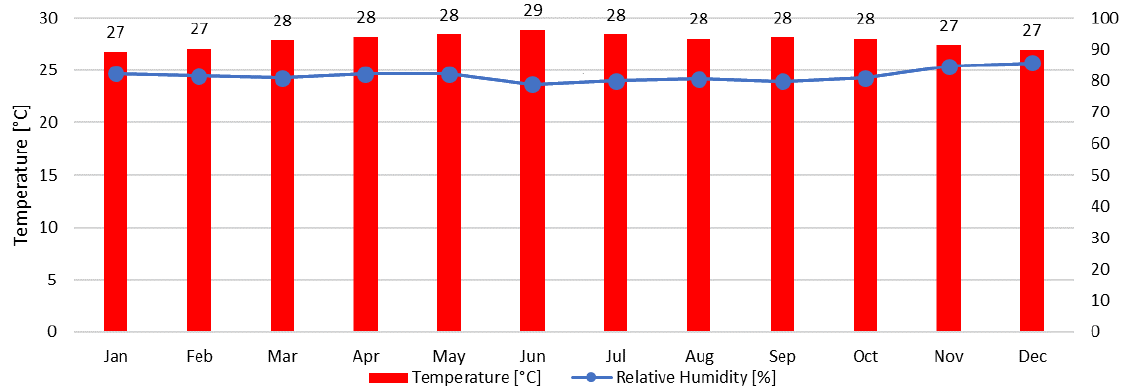
Figure 7. Singapore, t and r.h. during the average Figure 7. S ingapore, t and r.h. during the average year.